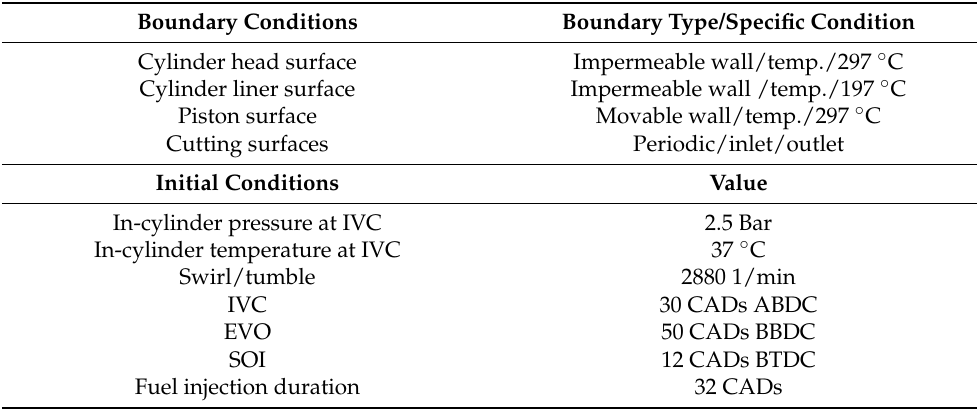
Table 3. BCs and initial conditions for CFD